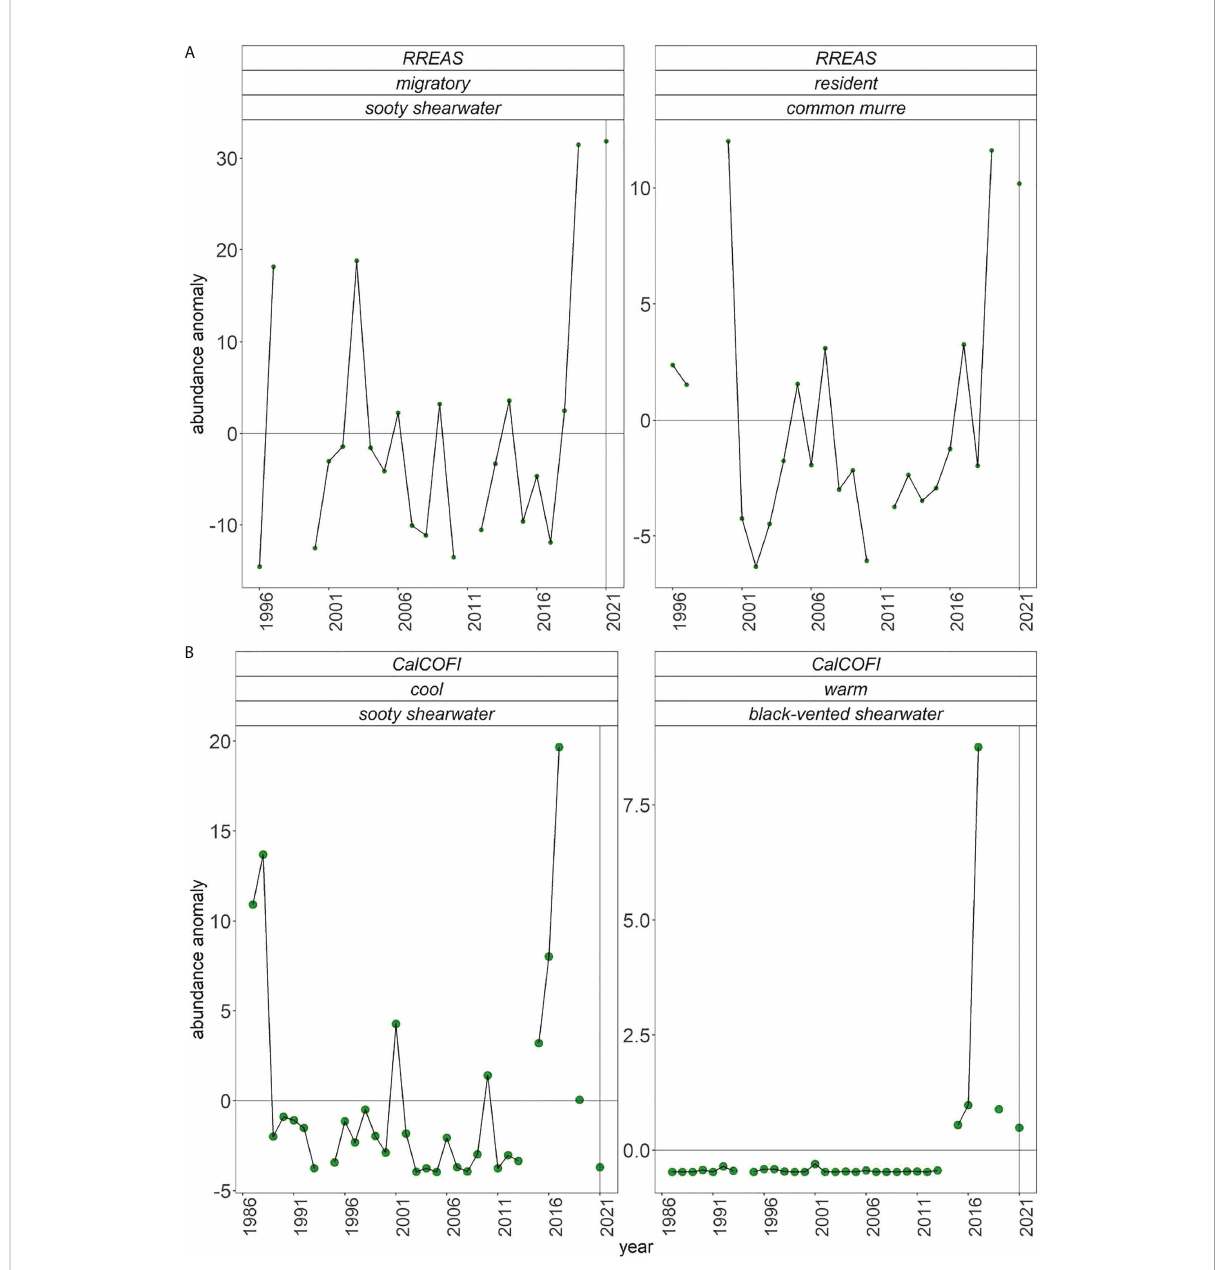
FIGURE 8 (A) Anomalies of at-sea sightings of migratory and resident sea birds from RREAS and (B) cool- and warm-water birds from summer